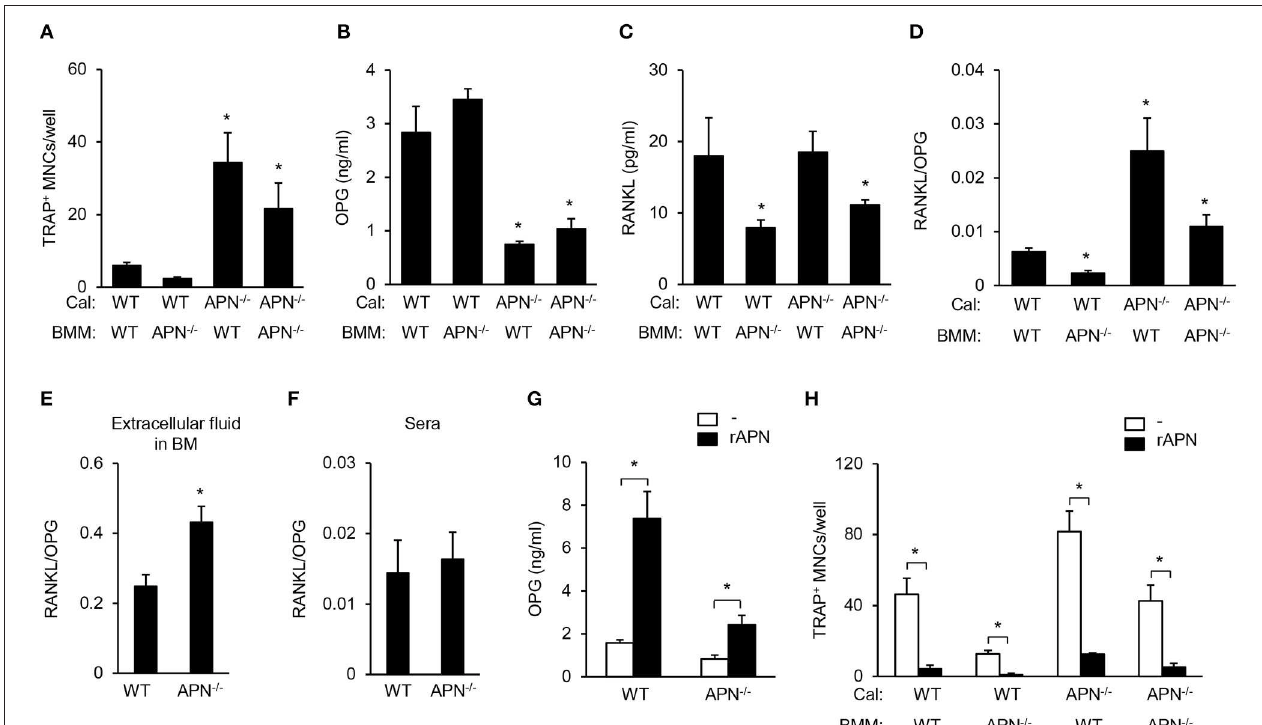
FIGURE 6 | Adiponectin-deficient calvarial cells induce osteoclast differentiation through attenuated production of OPG. (A) Calvarial cells and BMMs were co-cultured in the presence of 1 α ,25-dihydroxyvitamin D 3 (50nM) for 7 days. After TRAP staining, the number of TRAP + MNCs was measured. (B–D) At day 3 after co-culture, the culture supernatants were analyzed to measure the levels of (B) OPG and (C) RANKL. (D) RANKL/OPG ratio was calculated. * P < 0.05 compared with the wild-type control. (E,F) Bone marrow extracellular fluids were obtained by sequentially flushing two tibiae with 500 µ l of pre-chilled PBS followed by collecting the supernatant after centrifugation. Serum was separated from blood drawn from mice. The ratio of RANKL/OPG was calculated using the protein levels of RANKL and OPG in (E) bone marrow extracellular fluid and (F) serum. (G) Wild-type and adiponectin-deficient calvarial cells were treated with recombinant adiponectin (2 µ g/ml) for 3 days and the production of OPG was measured in the culture supernatant. (H) Calvarial cells and BMMs were co-cultured with recombinant adiponectin (2 µ g/ml) in the presence of 1 α ,25-dihydroxyvitamin D 3 (50nM) for 7 days. After TRAP staining, the number of TRAP + MNCs was measured. Cal, calvarial cells. Data are mean values ± SD of triplicate samples and are representative of three similar independent experiments. * P <